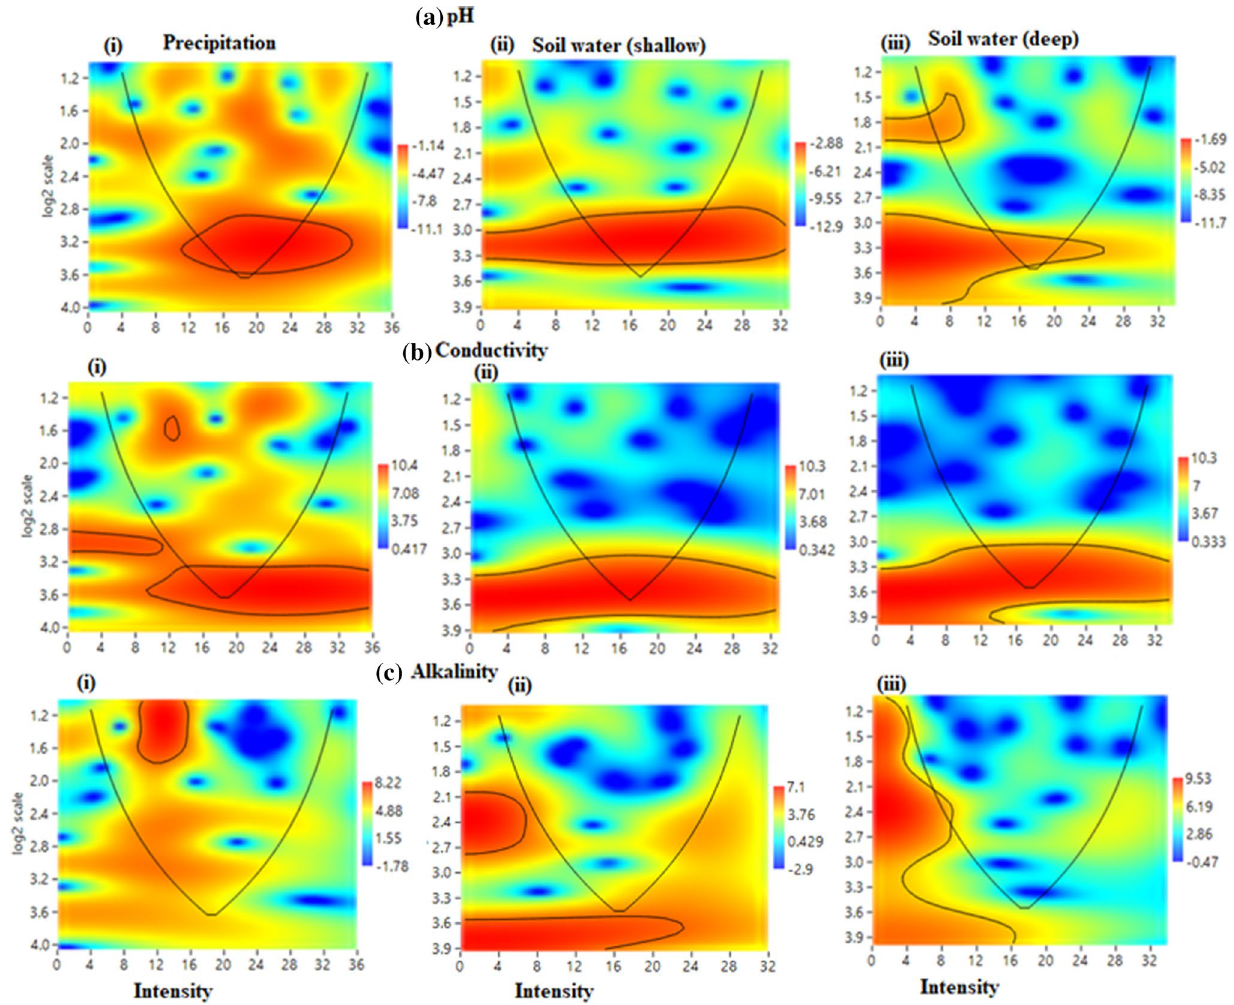
Fig. 5 Wavelet transform of selected physico-chemical variables in precipitation and soil water at the study